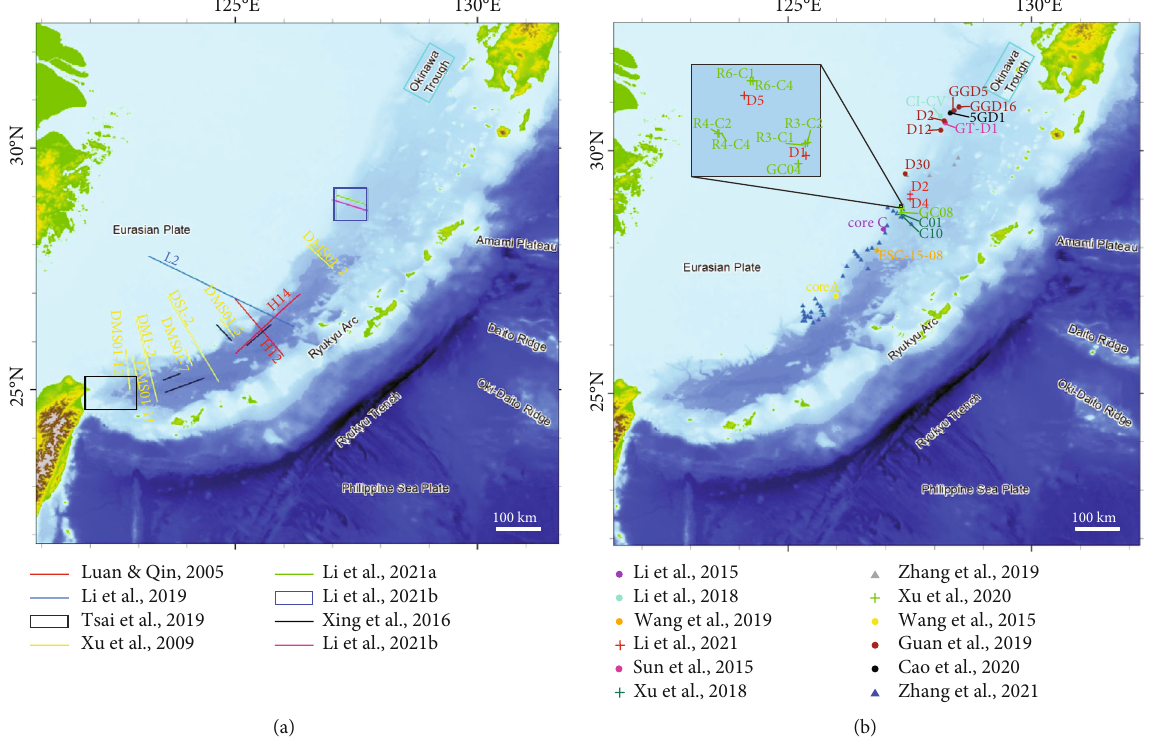
Figure 2: The locations of the seismic pro fi les (a) and the coring sites (b) documented in previous studies of methane seepage in the Okinawa